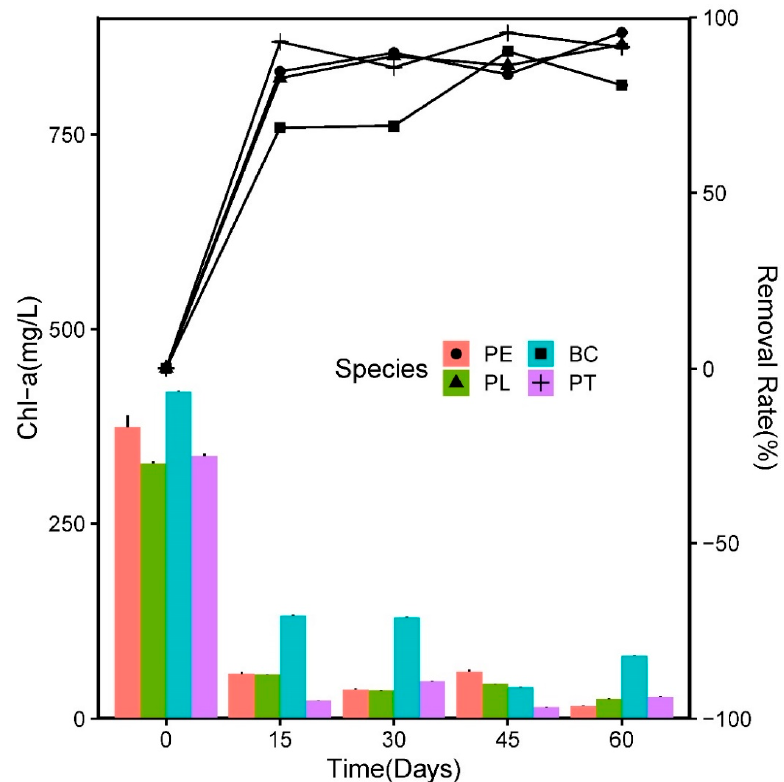
Int. J. Environ. Res. Public Health 2020 , 17 , x Figure 8. Variations in Chl-a concentration and the homologous removal rate in the experiment.